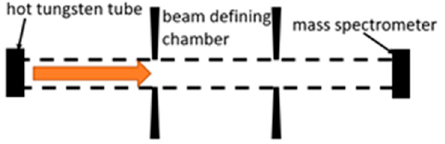
Figure 4. Schematic of the atomic beam plasma system, which was exclusively used in conjunction with mass spectrometry in the referenced works.